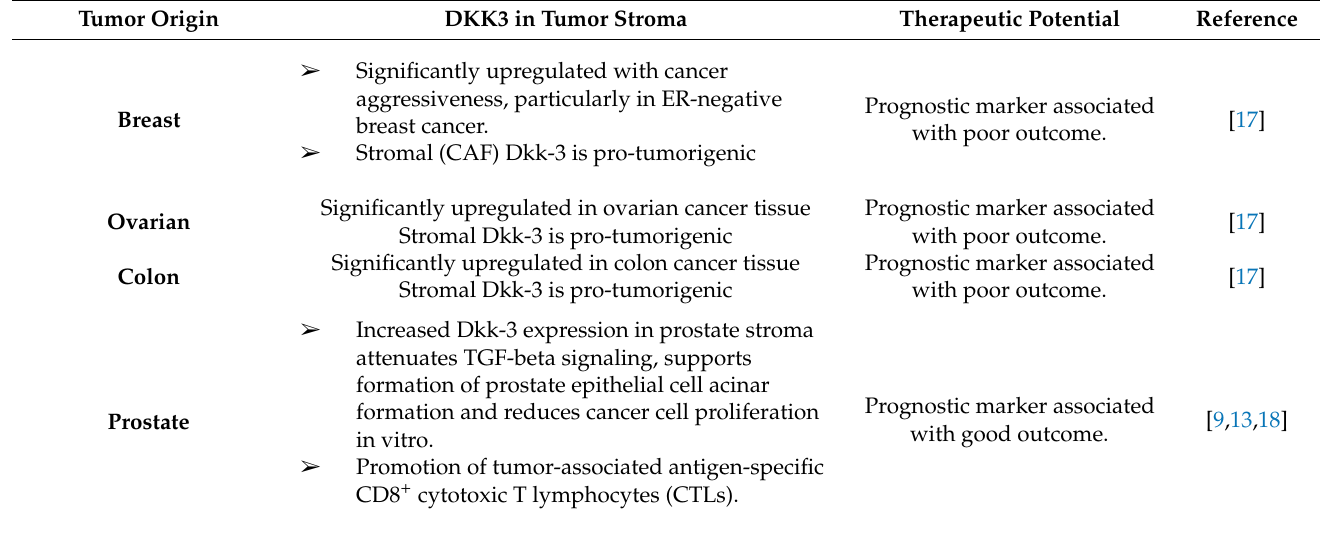
Figure 1. Participation of DKK3 in multiple cell and tissue settings. ( A ) Upregulated stromal Dkk-3 in blood vessels destabilizes angiopoietin 1 (ANGPT1) and promotes microvessel formation (according to Zenzmaier et al., 2013). ( B ) Dkk-3 promotes IL-7 secretion and increases CD8+ cytotoxic T lympho- cyte (CTLs) infiltration, and hence inhibits cancer tumorigenesis (according to Kumon et al., 2016 and Watanabe et al., 2014). ( C ) Upregulated stromal Dkk-3 induces the trans-differentiation of fibroblasts to myofibroblasts and increases fibroblast proliferation (according to Zenzmaier et al., 2013). The role of DKK3 in the modulation of the cancer microenvironment and its therapeutic